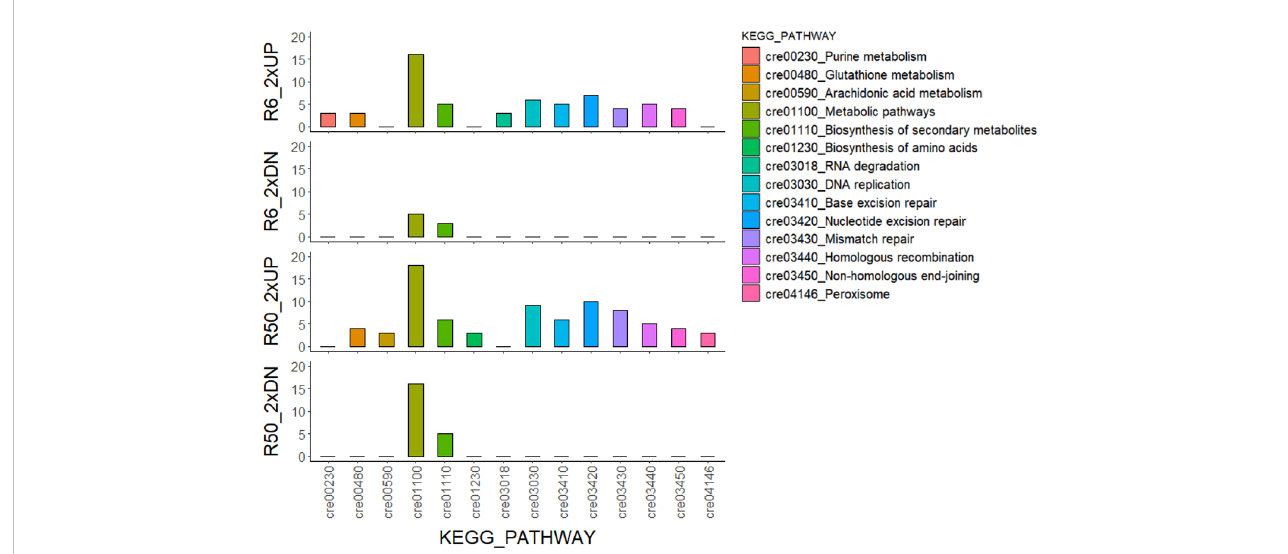
FIGURE 5 KEGG pathway analysis of genome-wide transcriptomic changes in C. reinhardtii cells after X- or g -irradiation with two different doses. The numbers of common genes with a more than two-fold transcription change in both XR6 and GR6 (or XR50 and GR50) groups are 694 and 443 (or 824 and 541) for 2×UP and 2×DN, respectively. XR6 (GR6) and XR50 (GR50) represent X-rays ( g -rays) of 6 and 50 Gy,